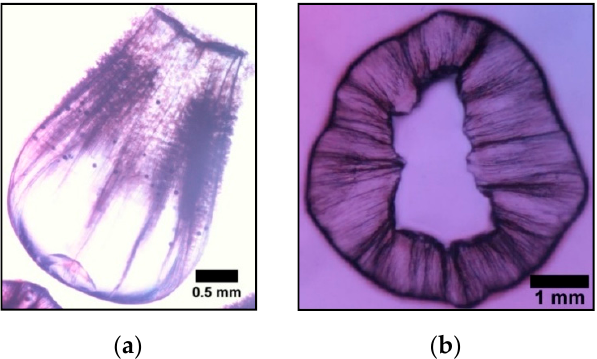
Figure 14. Zinc sulphate mineral vesicle: ( a ) lateral view; ( b ) hollow vesicle with its opening.